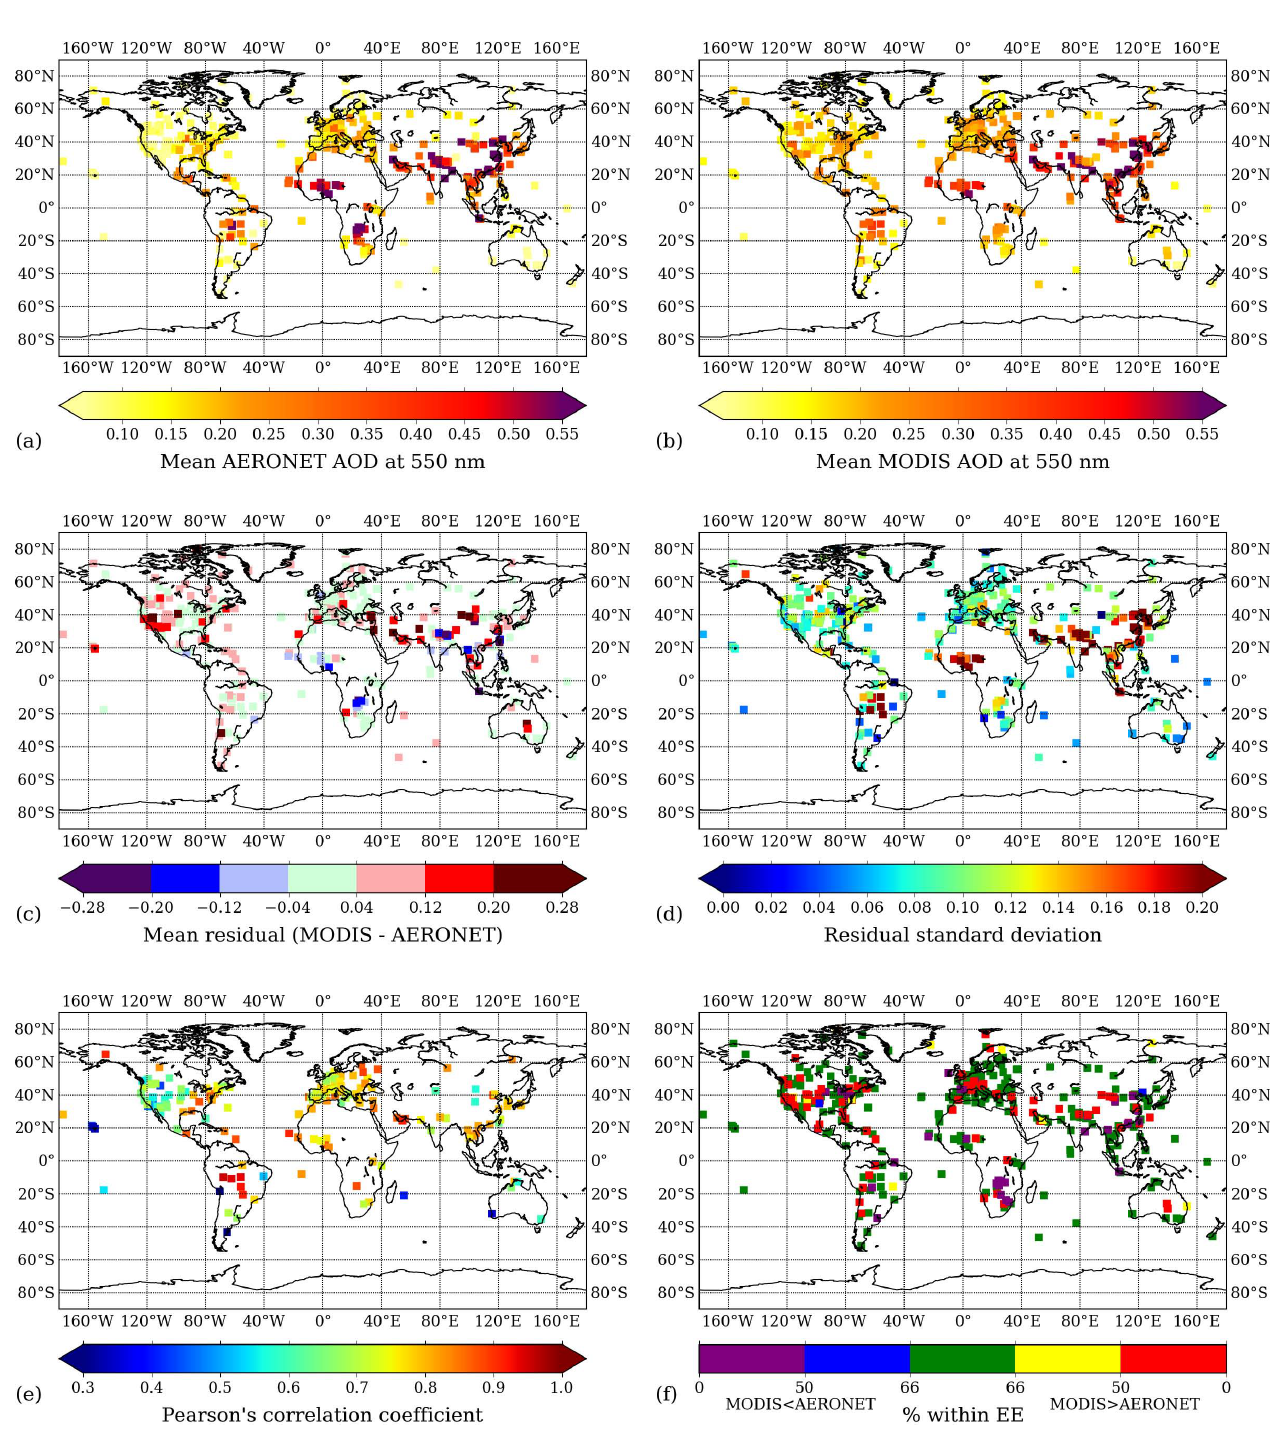
Fig. 2. Statistical scores calculated at experimental sites from the AERONET and L3 MODIS AOD collocations over the entire study period: (a) mean AERONET AOD at 550nm; (b) mean L3 AOD at 550nm; (c) mean residual; (d) standard deviation of the residual; (e) Pearson’s correlation coefficient; and (f) frequency of data points within the L2 AOD expected error (EE) interval.